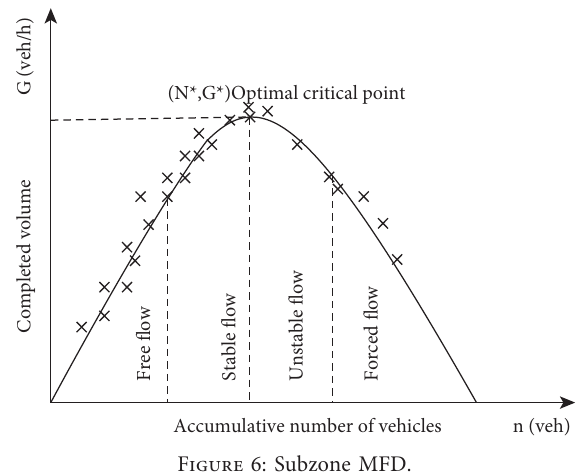
Figure 6: Subzone MFD.